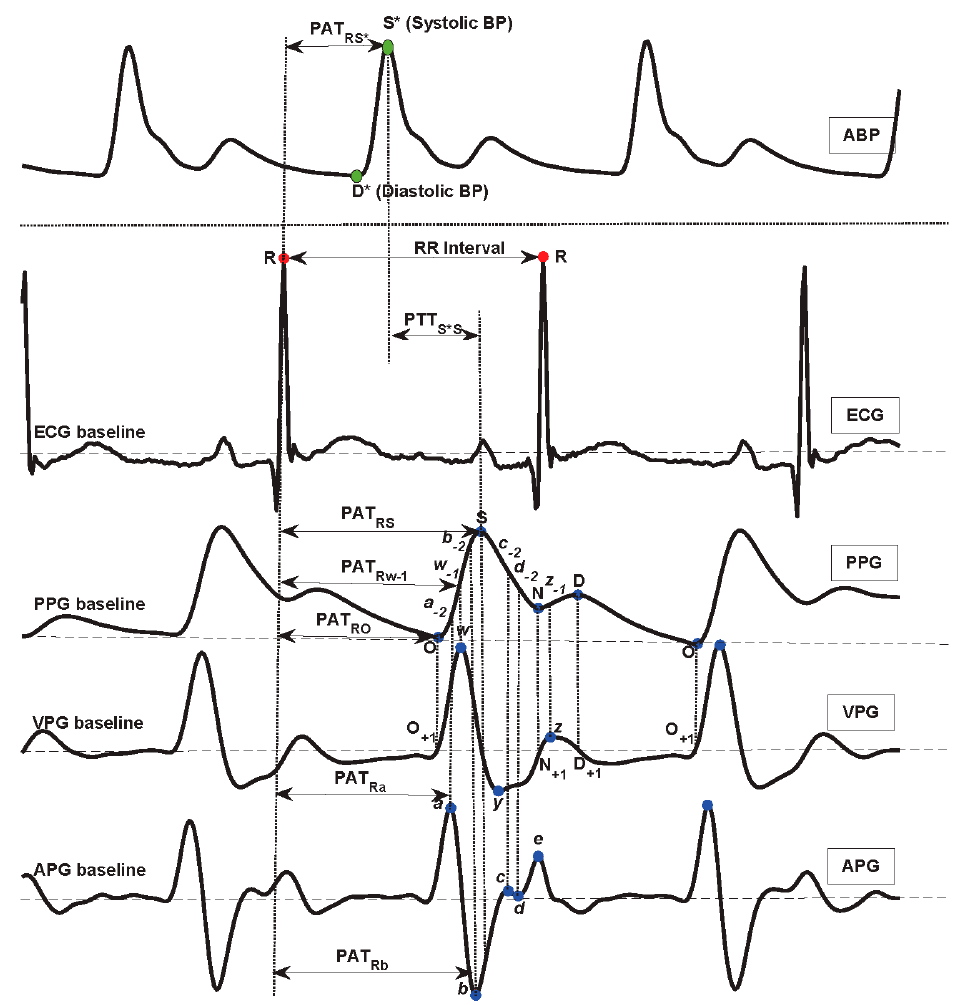
Figure 3. The characteristic point definition in ABP, ECG, PPG, VPG, and APG waveforms. Here, PTT is the duration between two arterial sites, PAT is the duration between the ECG R peak and a distal arterial waveform, ABP is the arterial blood pressure, ECG is the electrocardiogram, PPG is the photoplethysmogram signal, VPG is the velocity of PPG, APG is the acceleration of PPG, PTT is the pulse transit time, and PAT is the pulse arrival time.